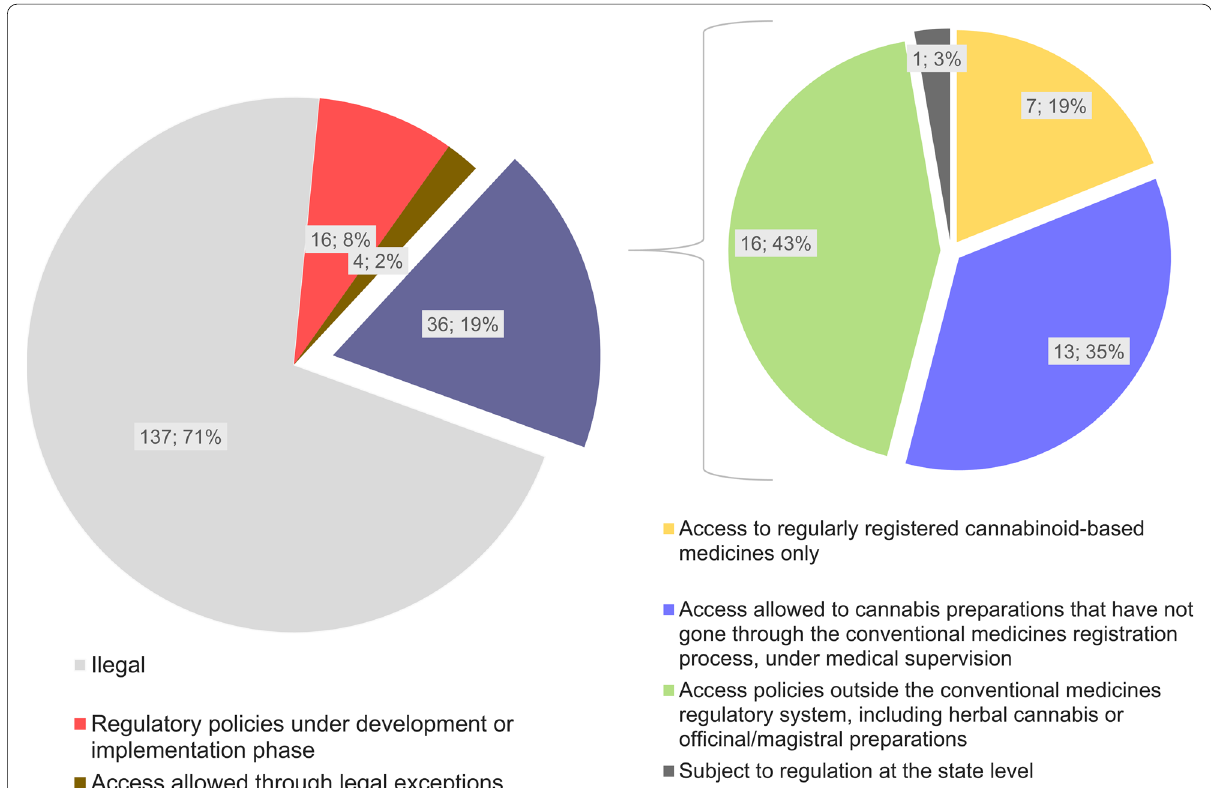
Fig. 1 Regulatory models regarding access to medical cannabis around the world and their classification according to the types of available cannabis-based pharmaceutical products. The classification is based on data obtained from October 2020 to March 2021. The sources of the original information regarding the assessed models are listed in the supplementary